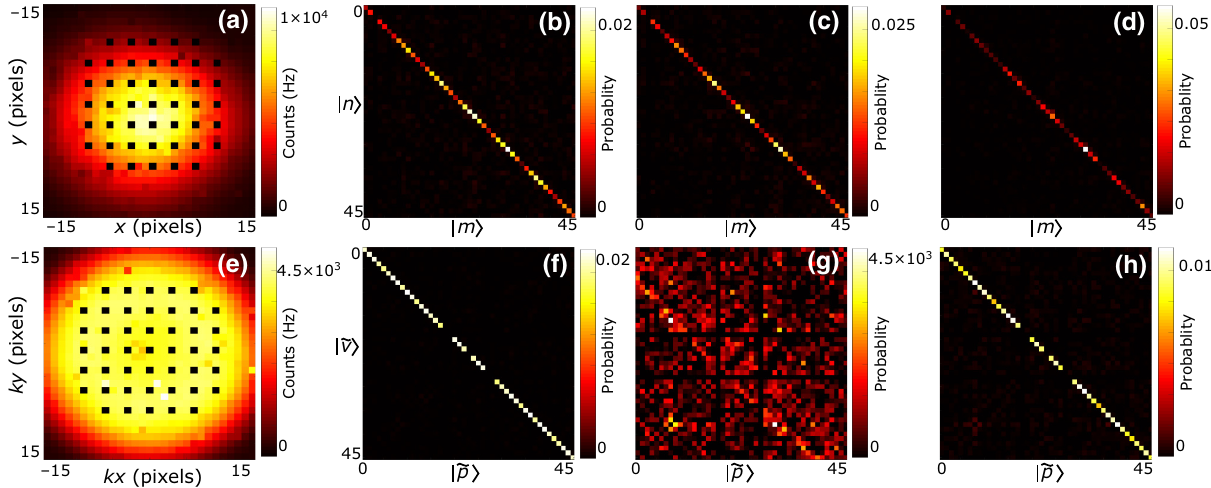
FIG. 3. Entanglement certification. (a) An intensity image acquired in the position-basis configuration, showing the grid of 45 pixels. (b)–(d) Correlation matrices between all the pixels in the grid of the position basis (b) without the medium, (c) with the medium and a flat SLM, and (d) with the medium and a correction SLM. Each pixel is labeling the spatial coordinates of the photon: | m (cid:6) in the position basis. (e) An intensity image acquired in the momentum-basis configuration, showing the grid of 45 pixels. (f)–(h) Correlation matrices between all the pixels in the grid in the momentum basis (f) without the medium, (g) with the medium and a flat SLM, and (h) with the medium and a correction SLM. Each pixel is labeling the spatial coordinates of the photon: | (cid:2) p (cid:6) in the momentum basis. Analysis is performed on a total of 1.5 × 10 9 images. The black lines and columns are associated with hot pixels of the sensor being set to